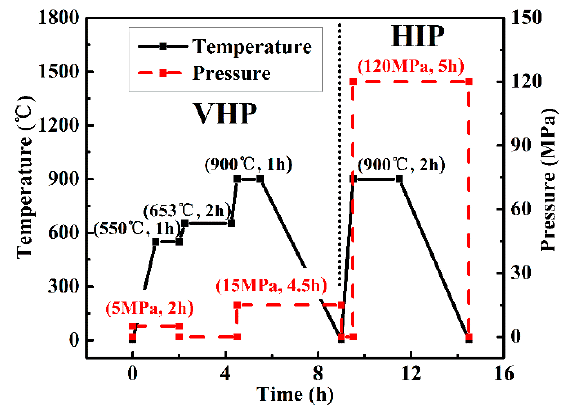
Figure 2. Schematic illustration of the hybrid processing technology.